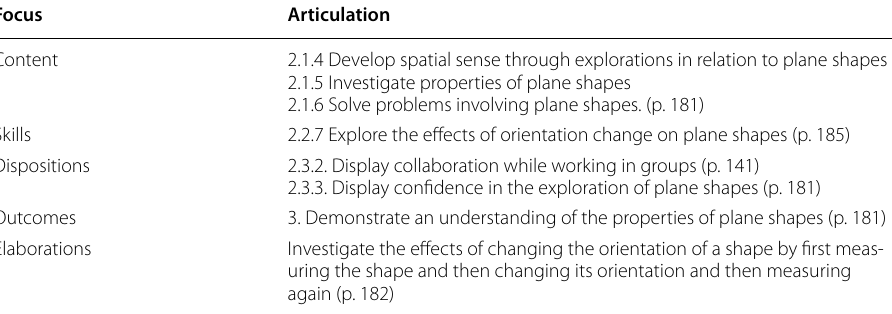
Table 1 Curriculum content for geometry strand in the TTNPMC (2013)